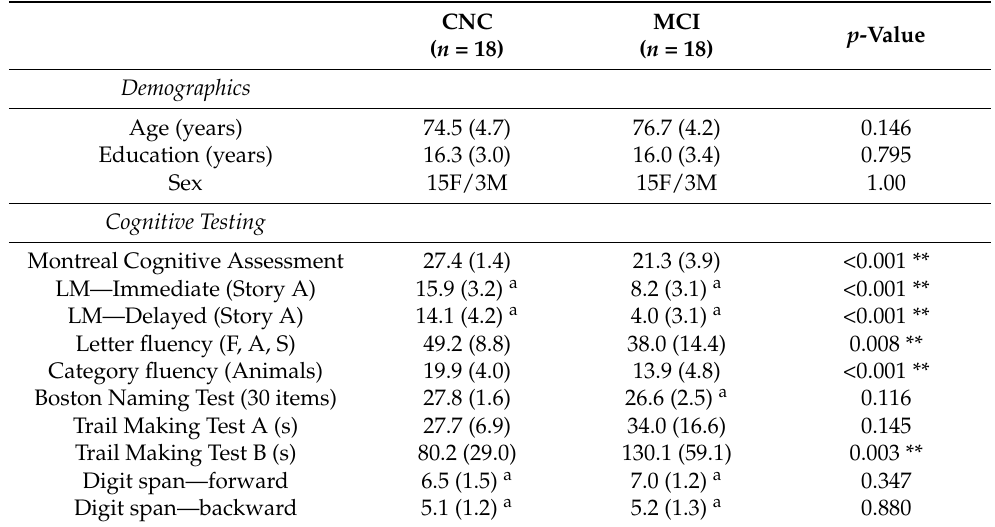
Table 1. Participant Demographics and Cognitive Testing